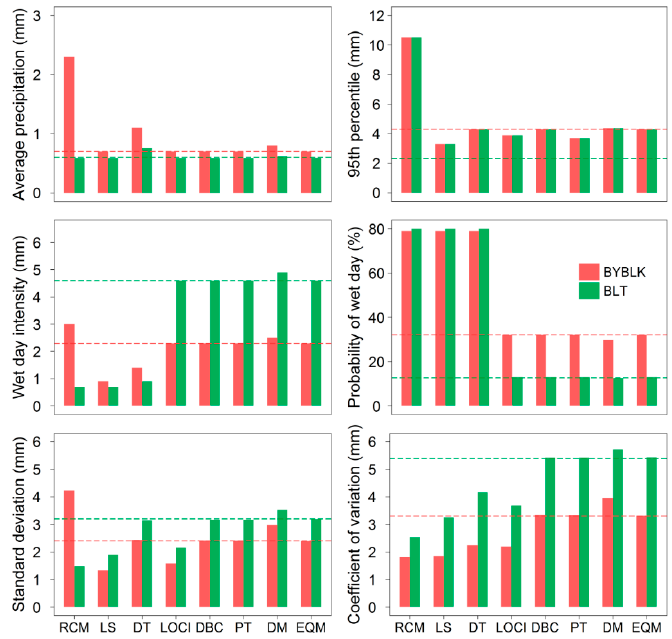
Figure 8. The wet day intensity, probability of wet days, 95th percentile, average precipitation intensity, standard deviation, and coefficient of variation at BYBLK and BLT meteorological stations in the period 1965–2004.